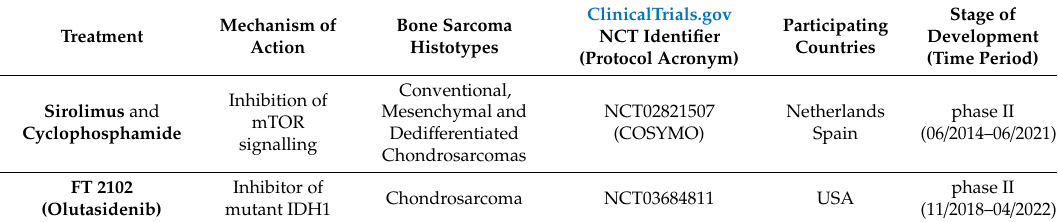
Table 2. List of target-specific clinical trials that are presently active and recruiting chondrosarcoma patients. Trialsthatarealsorecruitinghigh-gradeosteosarcomapatientsarelistedinTable1. Timeperiod refer to the actual study start date and estimated study completion